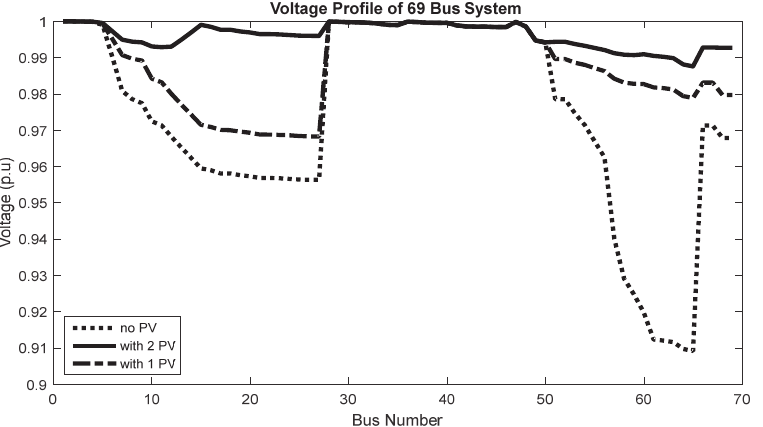
Figure 8. Voltage profile of the 69 ‐ bus distribution system.